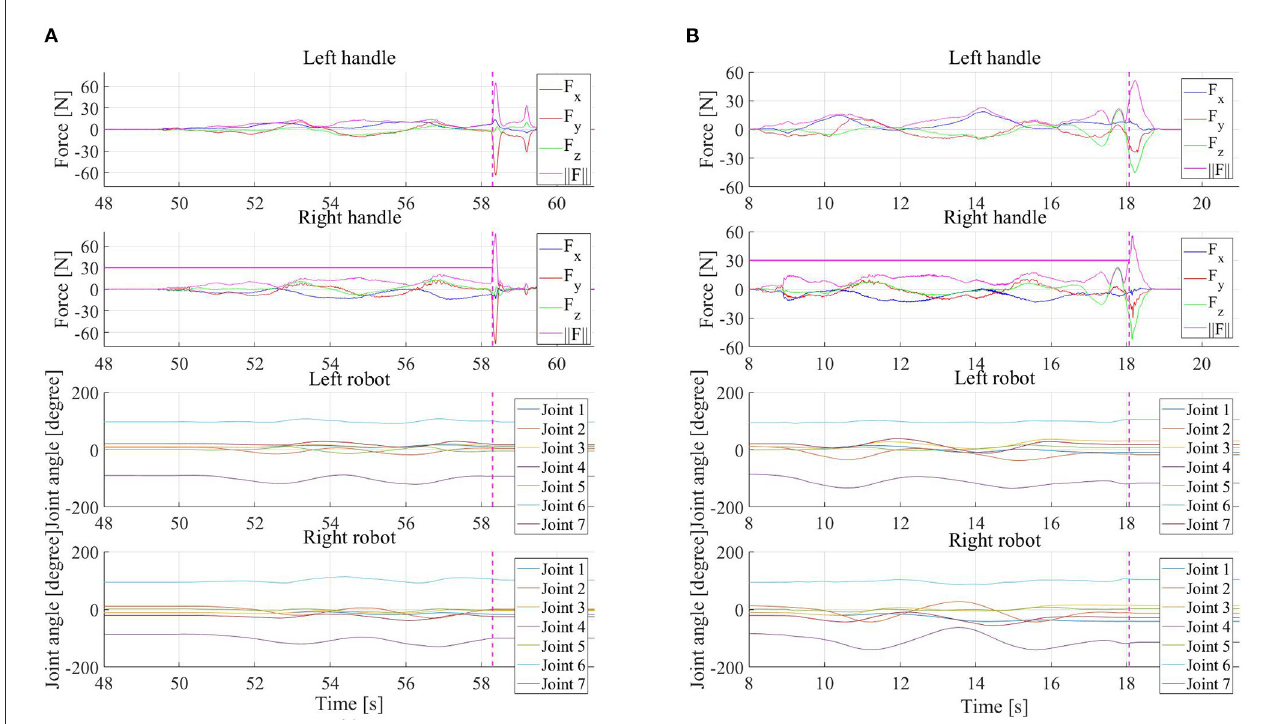
FIGURE9 Force profiles of two handles applied by operator hands and joint trajectories of the two robots of PREDICTOR when the operator suddenly applied a force larger than a force limit of 30N (A) , and those when the Cartesian impedance controller of the virtual robot in the simulator was underdamped in vertical direction (B) . The dashed vertical pink lines indicate when the system was halted because the handle force magnitude reached the limit and the horizontal pink lines show which handle triggered the safety mechanism to halt the system in the two